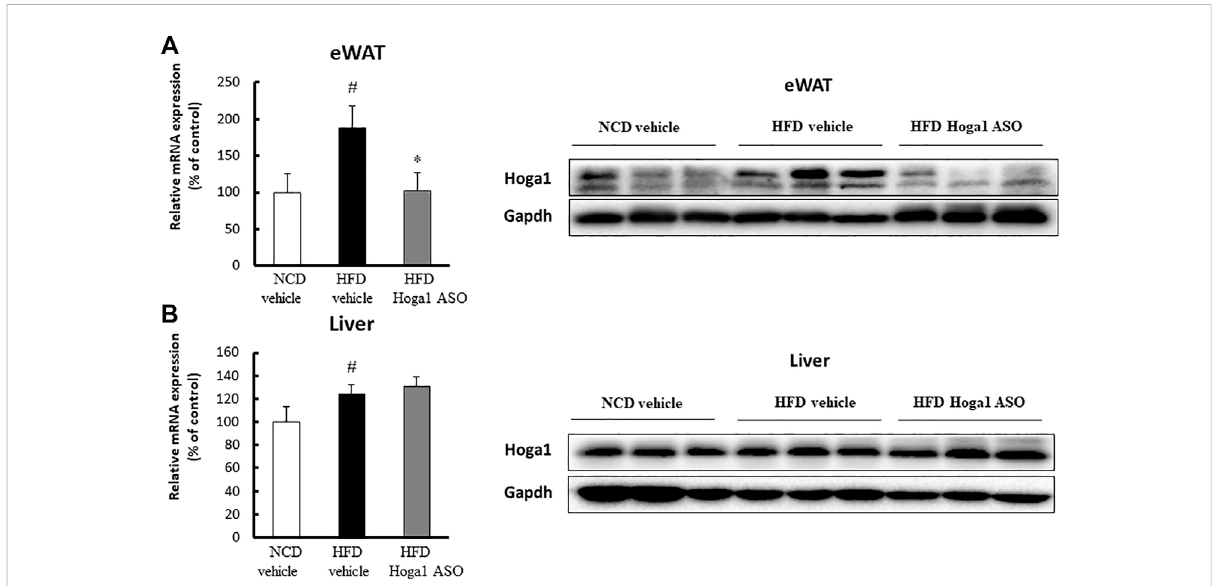
FIGURE 4 Increased Hoga1 expression in adipose tissues of diet-induced obese mice. High-fat diet (HFD) C57BL/6J mice were treated with Hoga1 ASO (HFD Hoga1 ASO) or scrambled control ASO (HFD vehicle) twice per week (25 mg per kg body weight per dose) for 6 weeks. In addition, normocaloric diet (NCD) mice were treated with scrambled control ASO (NCD vehicle). The mRNA and protein levels of Hoga1 in epididymal white adipose tissue (eWAT) (A) and in the liver (B) of the NCD vehicle, HFD vehicle, and HFD Hoga1 ASO groups were measured by qRT-PCR (left panel) and Western blot (right panel) analyses, respectively. Five mice were used per group ( # p < 0.05 indicates a signi fi cant difference between the NCD vehicle and HFD vehicle; * p < 0.05 indicates a signi fi cant difference between the HFD vehicle and HFD Hoga1 ASO).